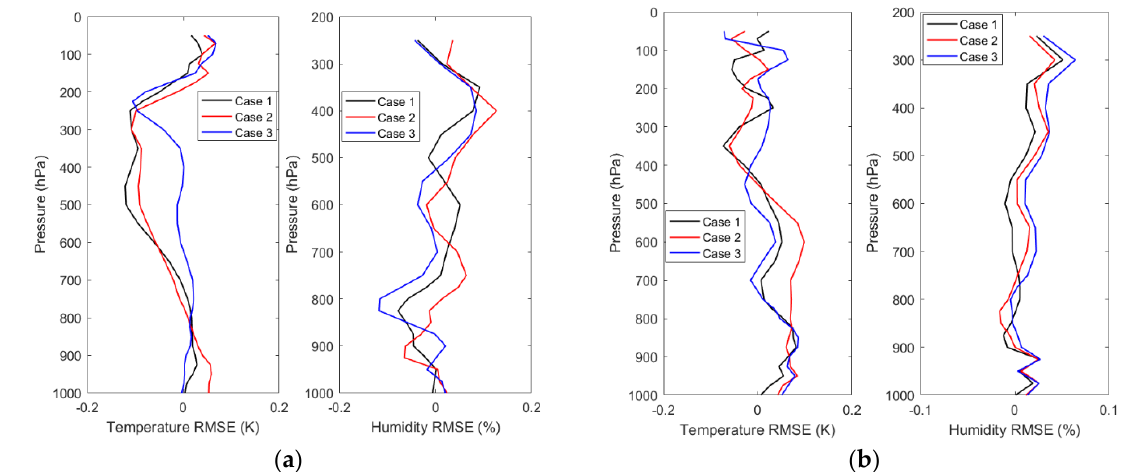
Figure 14. The stability test results of the retrieval of atmospheric temperature and humidity based on SNN and DNN using MWHTS observations: ( a ) SNN and ( b ) DNN.